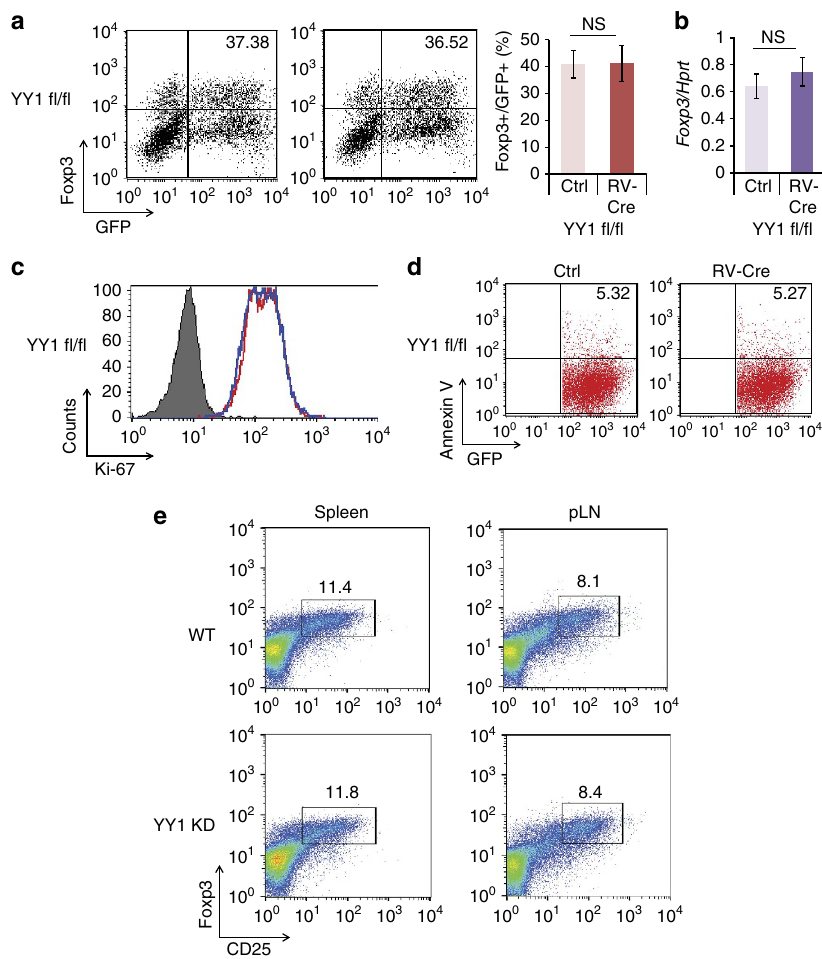
Figure 3 | YY1 deficiency does not influence Foxp3 expression. ( a ) Naı¨ve CD4 Tcells from YY1 fl/fl mice were transduced with either control vector or CRE-expressing vector (RV-Cre) and cultured under the T reg differentiation condition for 4 days. Foxp3 was stained and measured by flow cytometry. Numbers in the FACS plots indicate the percentage of Foxp3 þ cells from GFP þ cells. ( b ) GFP þ cells from a were sorted, and total RNA was isolated. A relative amount of Foxp3 was measured by qRT–PCR. ( c ) Proliferation of YY1-deficient T reg cells was detected with Ki-67 staining from GFP þ cells. ( d ) Apoptosis of YY1-deficient T reg cells was measured with Annexin V staining. Experiments were performed five times with similar results. ( e ) T reg populations in the spleen and peripheral lymph nodes of YY1 KD or WT mice were analysed by staining anti-CD4, anti-CD25 and anti-Foxp3. Cells were gated on CD4.